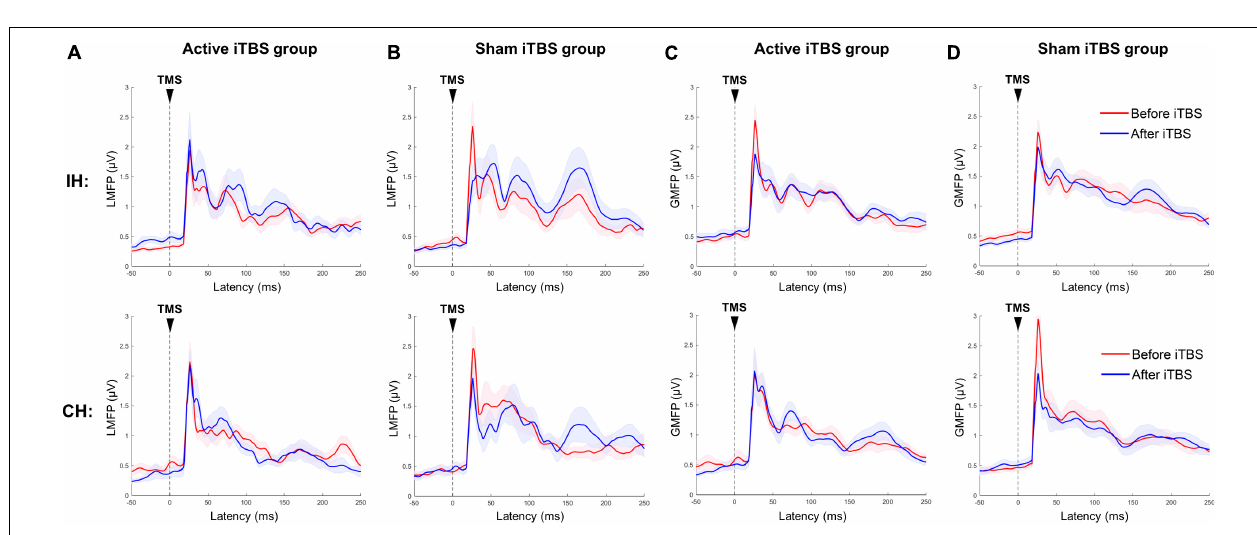
FIGURE 2 | Local and global mean field power changes after iTBS. Data presented are group mean ± standard error. The top panel presents the data in the IH, and the bottom panel presents the data in the CH. (A,B) LMFP in the Active and Sham TBS group, respectively. (C,D) GMFP in the Active and Sham TBS group, respectively. The red curves represent LMFP or GMFP before iTBS, and the blue curves represent LMFP or GMFP after iTBS. There was no significant change in LMFP or GMFP after iTBS in either